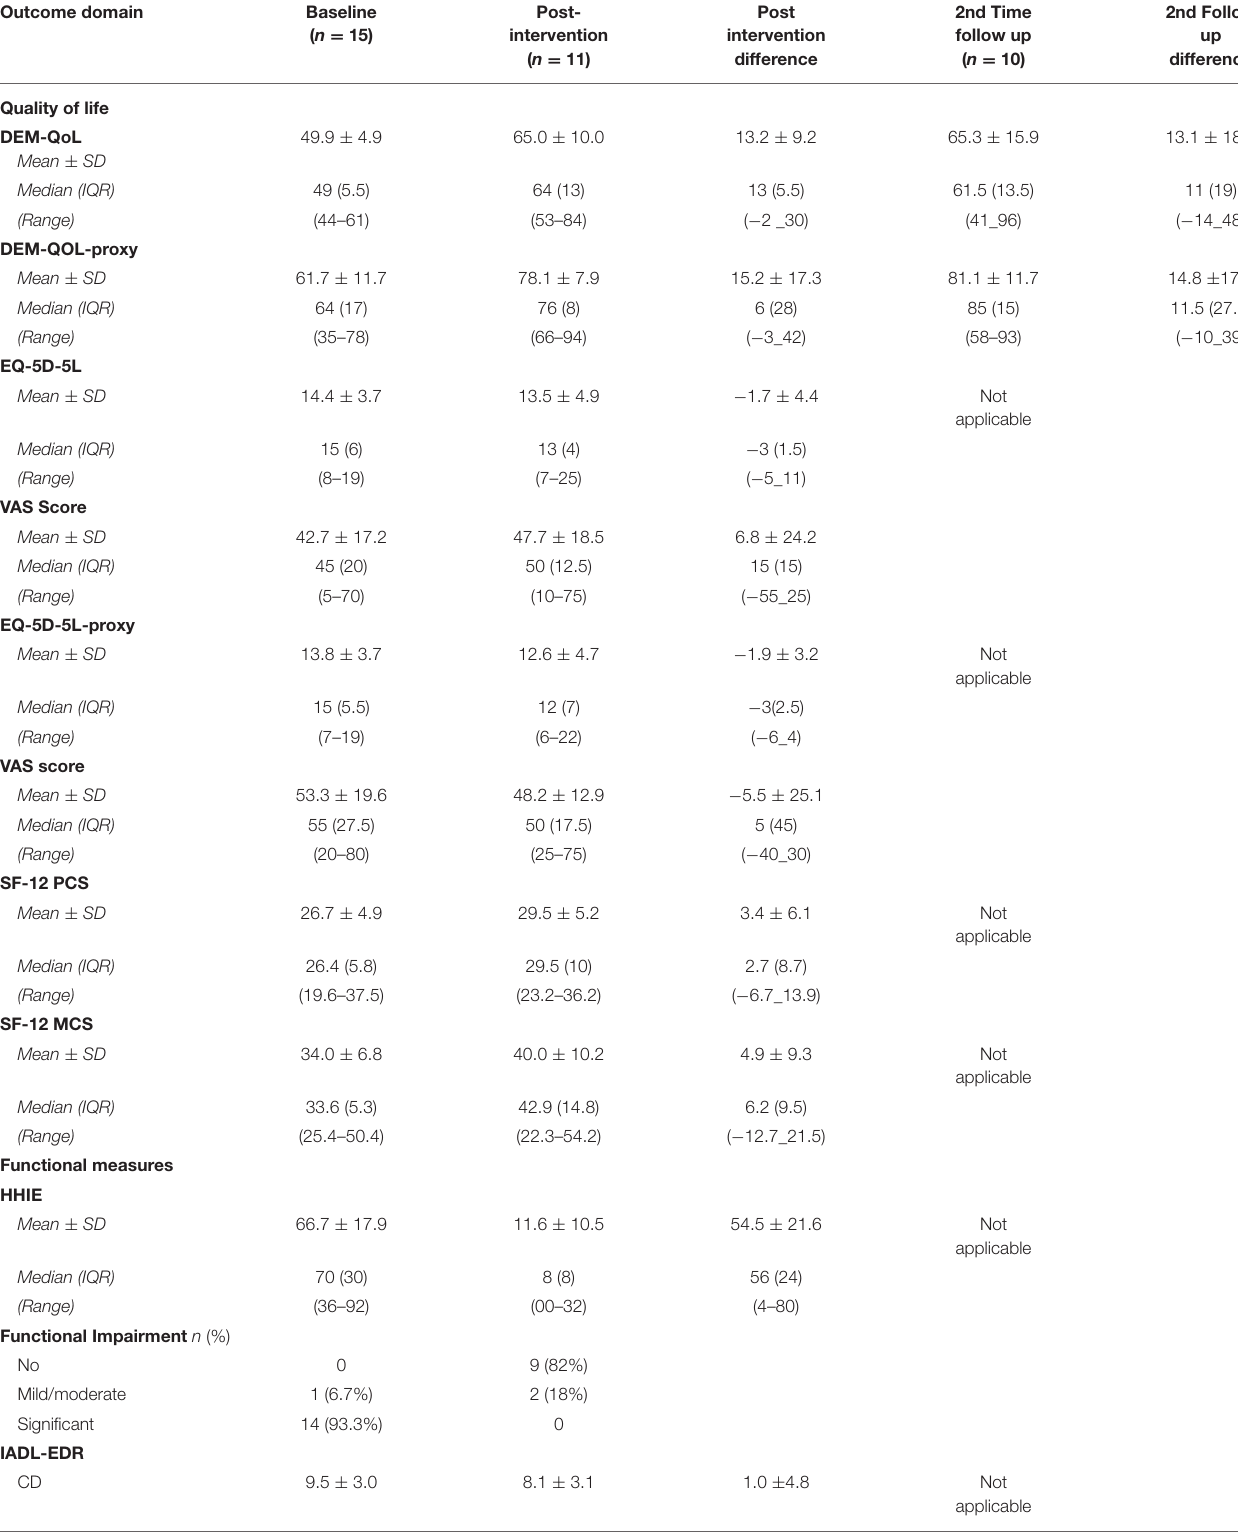
TABLE 6 | Baseline and post-intervention outcome measurements for the Participants with Dementia (PwD). Outcome